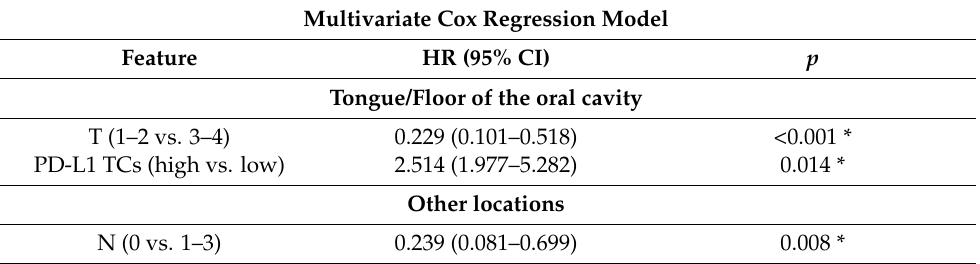
Table 3. The multivariate Cox’s regression models (HR—hazard ratio; 95% CI—confidence interval; p — p value; *—statistically significant p ).